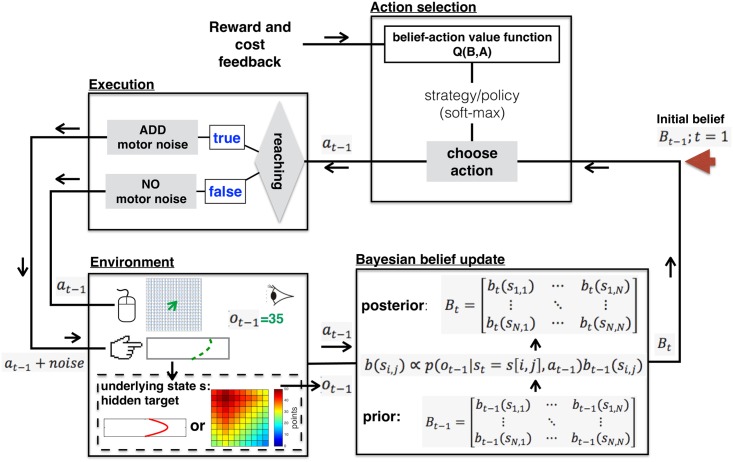
An illustration of the model for the decision-making task and the explorative motor learning task.On each trial, a hidden target is chosen (Environment). That is, the environment is in a state, which is not directly observable. The model starts with an initial uniformly distributed belief state (illustrated with the red arrow on the top right). On each time step, given an belief, the model then chooses an action based on the belief-action value function (Action selection). Subsequently, the action is executed (Execution). Decision-making task actions are performed without motor noise; the model is able to choose the selected action accurately. Reaching actions are performed with motor noise; there is uncertainty between the selected and executed action. Once the action is executed, the environment gives observable feedback (ot−1 = 35 in the figure). The action and observation are then used to update the belief (Bayesian belief update). The update is constrained by the fact that participants were naïve to the score function used. We modelled this uncertainty using the likelihood uncertainty parameter (Γ; Eq 3). A new cycle then starts with the new belief state (Bt).